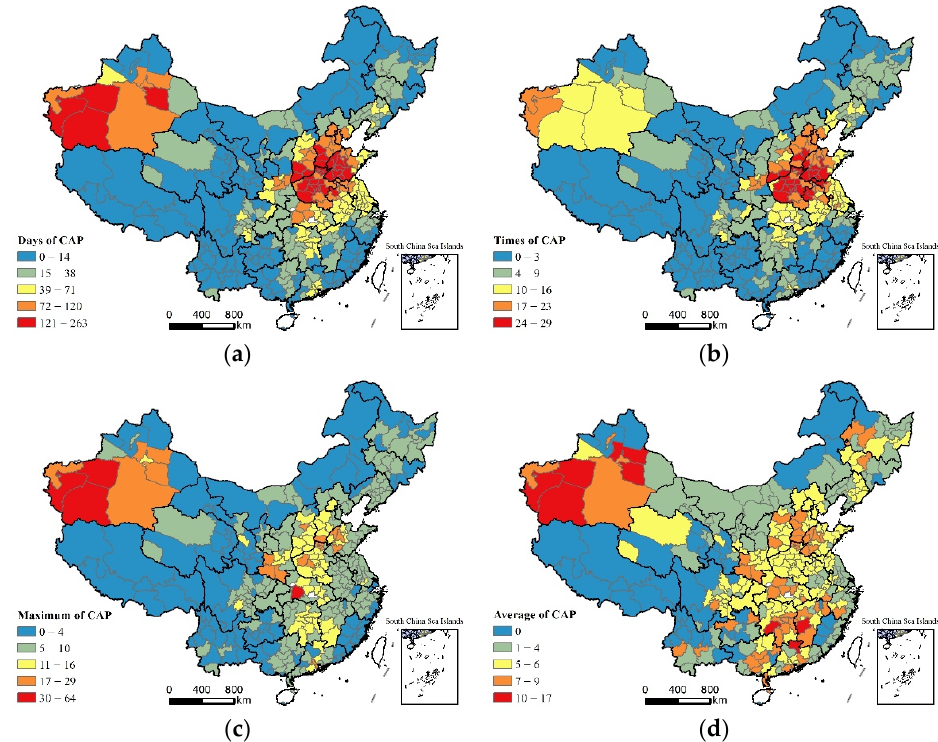
Figure 2. Spatial distribution of CAP-related measurement indicators in China: ( a ) spatial distribution of days of CAP; ( b ) spatial distribution of frequencies of CAP; ( c ) spatial distribution of maximum amount of CAP days; ( d ) spatial distribution of average amount of CAP days.